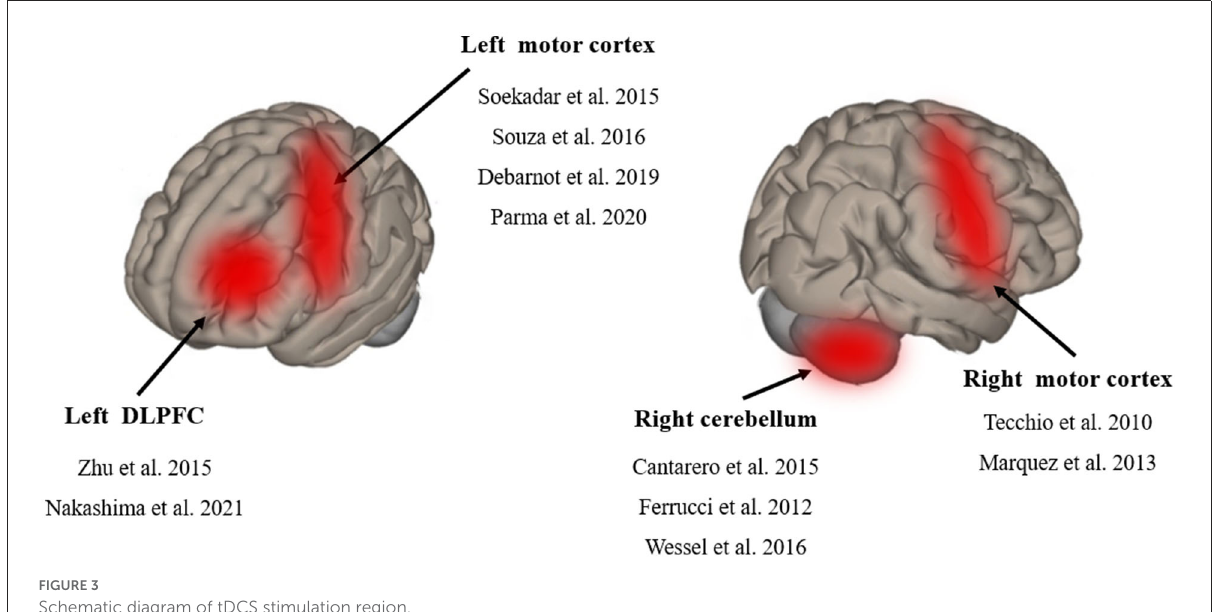
FIGURE3 Schematic diagram of tDCS stimulation region.